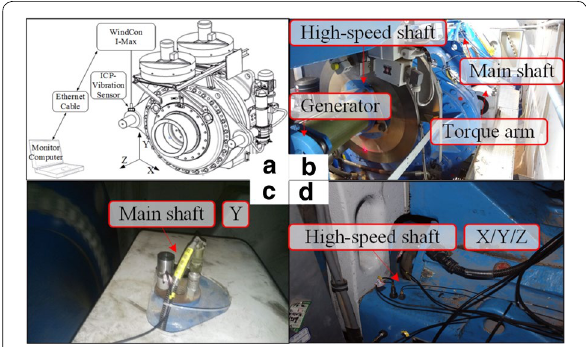
Figure 17 Experiment of drivetrain in wind field: a test principles, b installation of sensors, c measuring point of main shaft bearing and d measuring point of downwind bearing of high-speed shaft